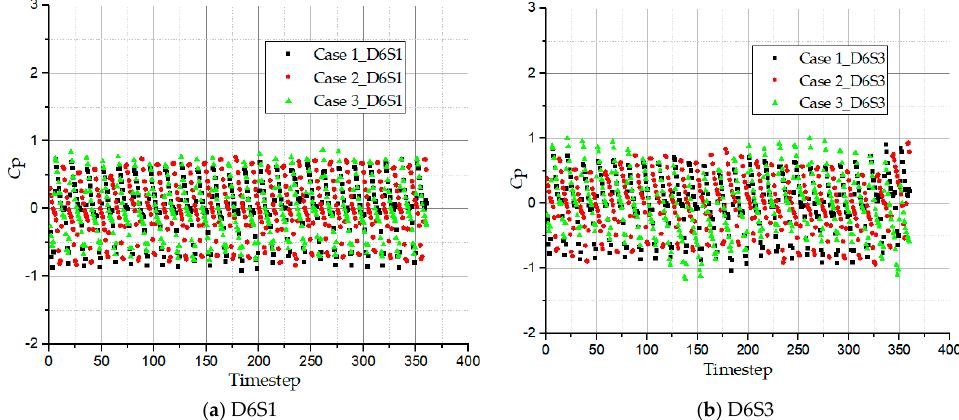
Figure 14. Time domain history of pressure fluctuation in side channel at 180 º offset region for all pump cases.